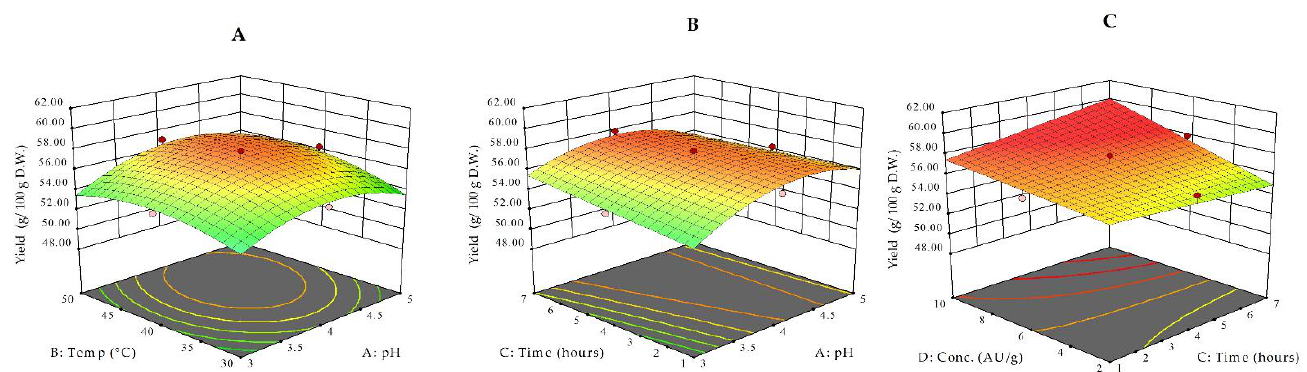
Figure 1. 3D response surface plots for extraction yield as a function of temperature and pH (at a constant time of 4 h and at a concentration of 6 AU/g) ( A ), time and pH (at a constant temperature of 40 °C and at an enzyme concentration of 6 AU/g) ( B ), and enzyme concentration and time (at a constant temperature of 40 °C and at a pH of 4) ( C ).